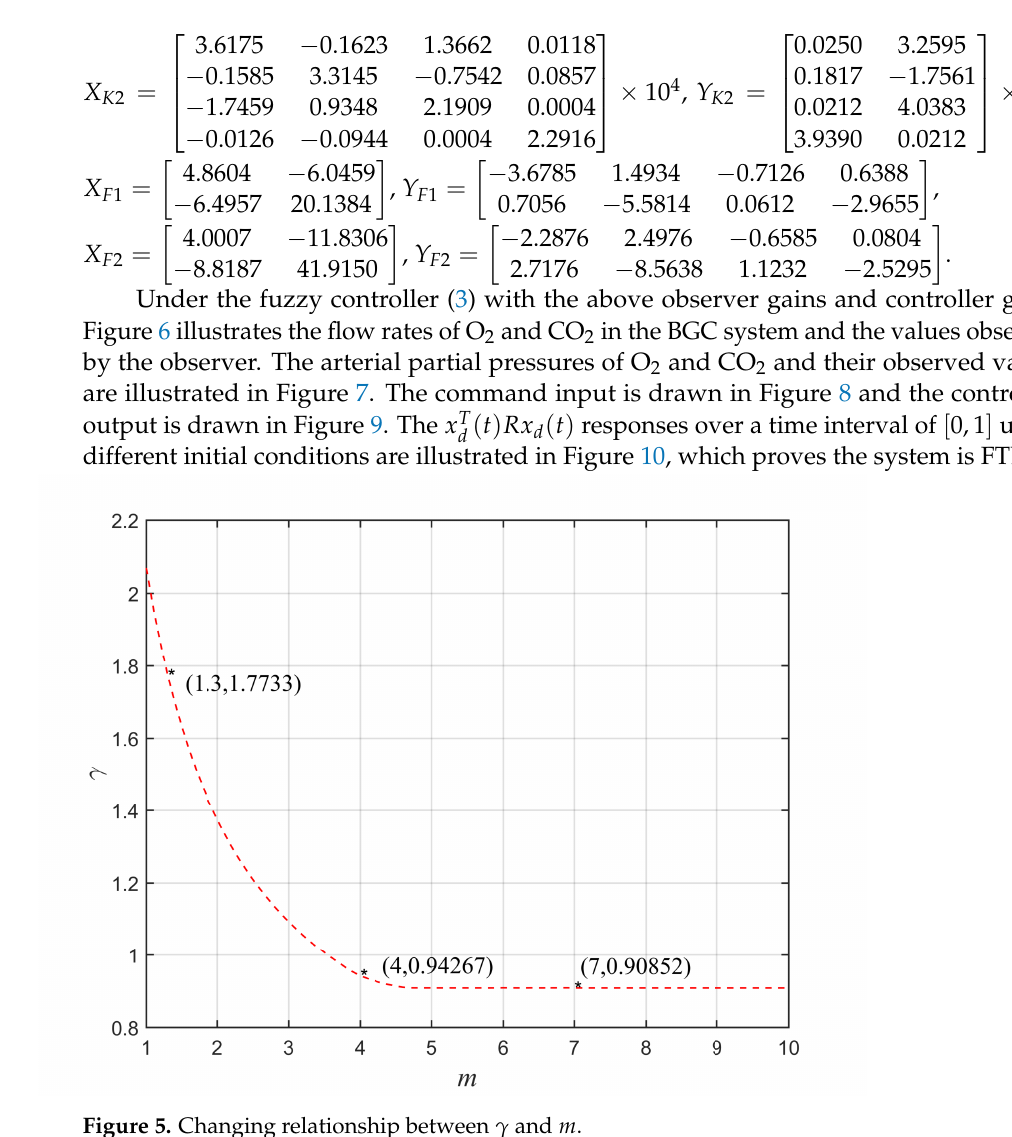
Figure 5. Changing relationship between γ and m .